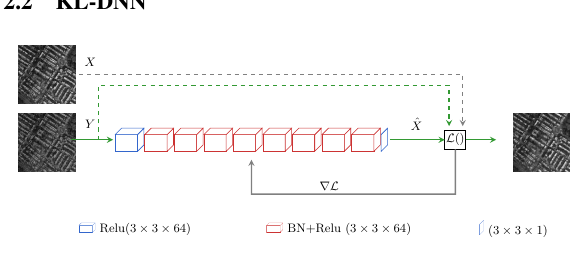
Figure 1. KL-DNN architecture